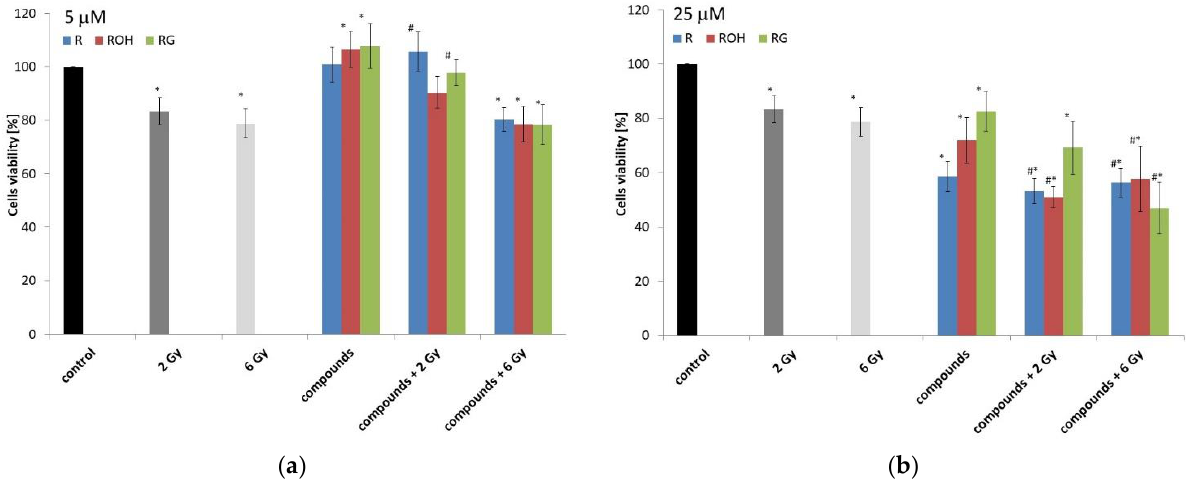
Figure 3. The MCF-7 cell viability under the effect of 5 ( a ) or 25 μM ( b ) of resveratrol (R), piceatannol (ROH), and piceid (RG) alone and in combination with ionising radiation (IR) (dose of 2 or 6 Gy) was determined using an MTT test after 48 h of incubation. All results are presented as the mean ± SD of three independent repetitions. Treatments were compared by a two-way analysis of variance (ANOVA) followed by Tukey’s post hoc test ( p < 0.05). The mean difference (*) was compared with the control and (#) with IR.